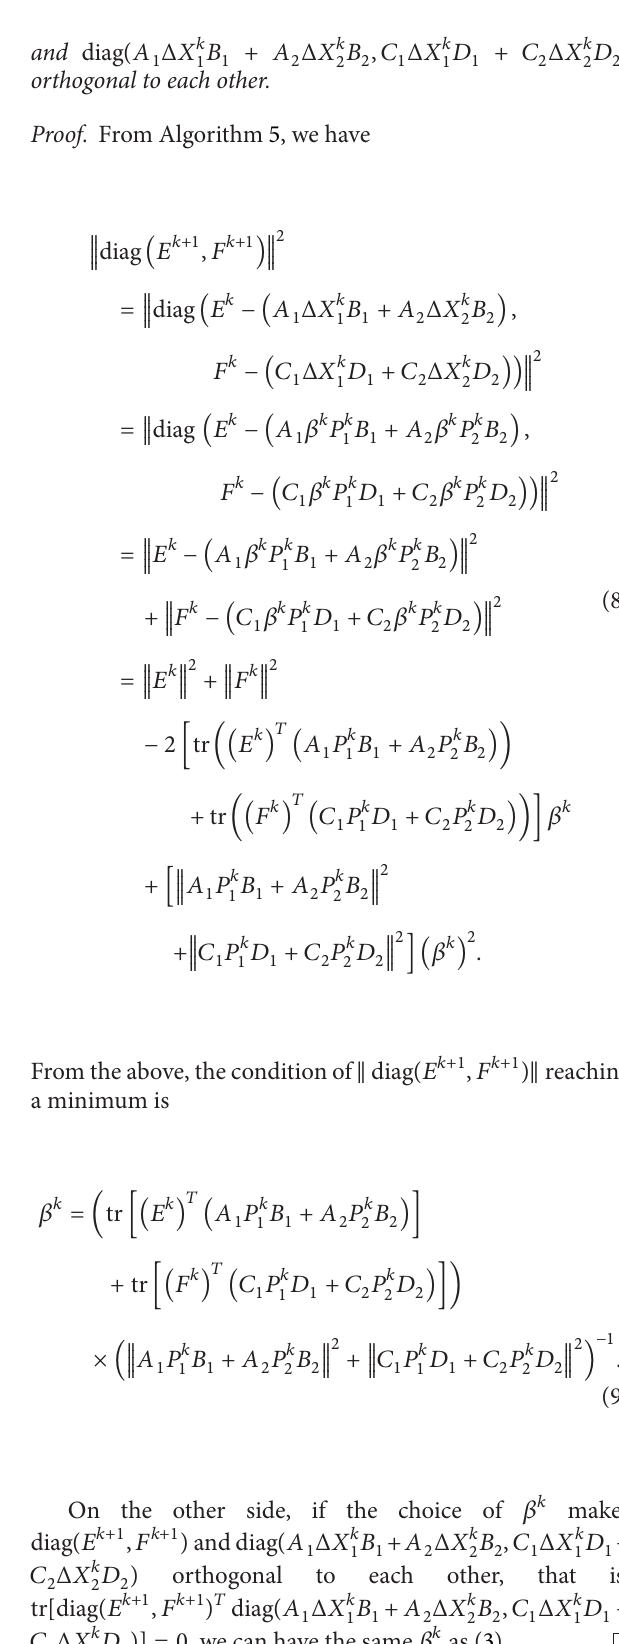
Algorithm 5. (1) Input matrices 𝐴 1 ∈ 𝑅 𝑝×𝑘 , 𝐴 2 ∈ 𝑅 𝑝×𝑚 , 𝐵 1